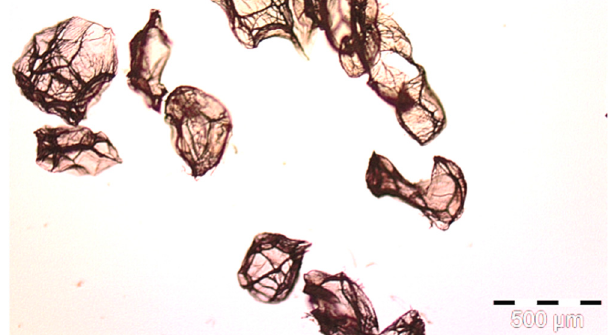
Figure 2. Microphotograph of prepared microcapsules filled with silver ion of 450 μ m in diameter, prior functionalization of polymers recorded by optical microscopy with high resolution.